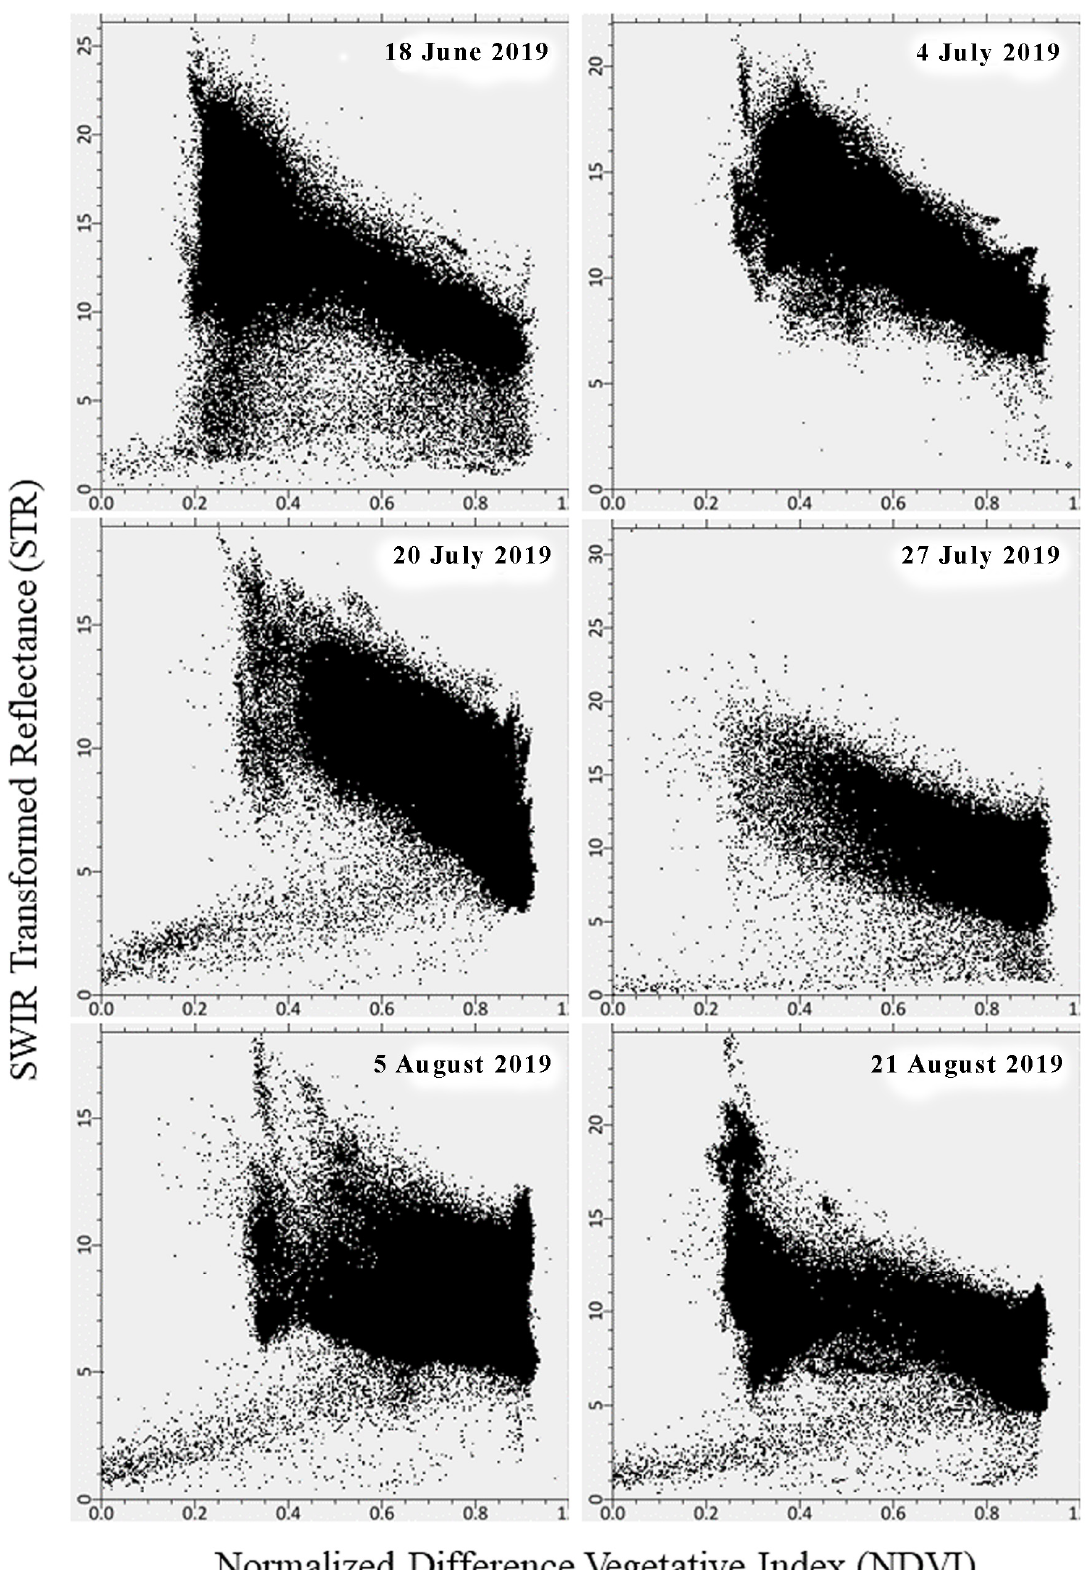
Figure 6. Pixel distributions within the SRT-NDVI space for all of the images for the 2019 growing season (18 June to 21 August) in the RRVN.